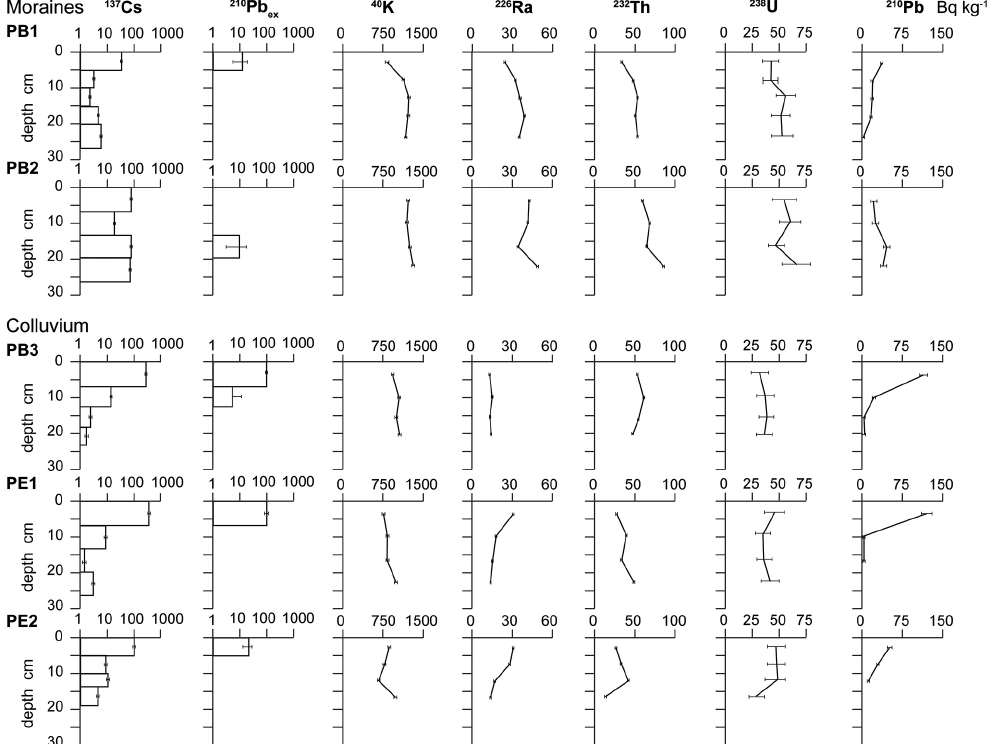
Figure 6. Depth distribution of the mass activities (Bq kg − 1 ) of FRNs and ERNs in the soil profiles on the moraines and colluviums.